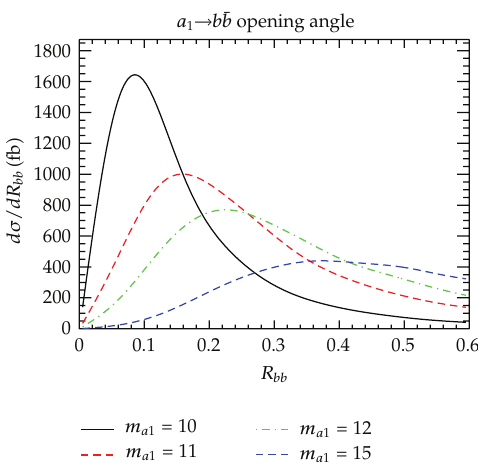
Figure 6: The distance between the two b -quarks coming from the a 1 -decay on parton level for the signal with m h ± (cid:7) 130GeV.